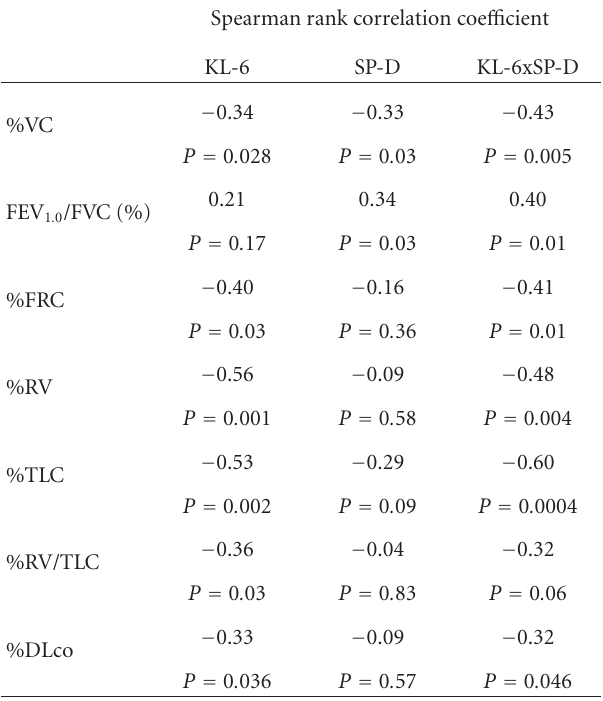
Figure 2: Ratio of patients with high serum levels of KL-6 and SP- D. Table 4: Correlation of pulmonary function tests with KL-6 and SP-D.